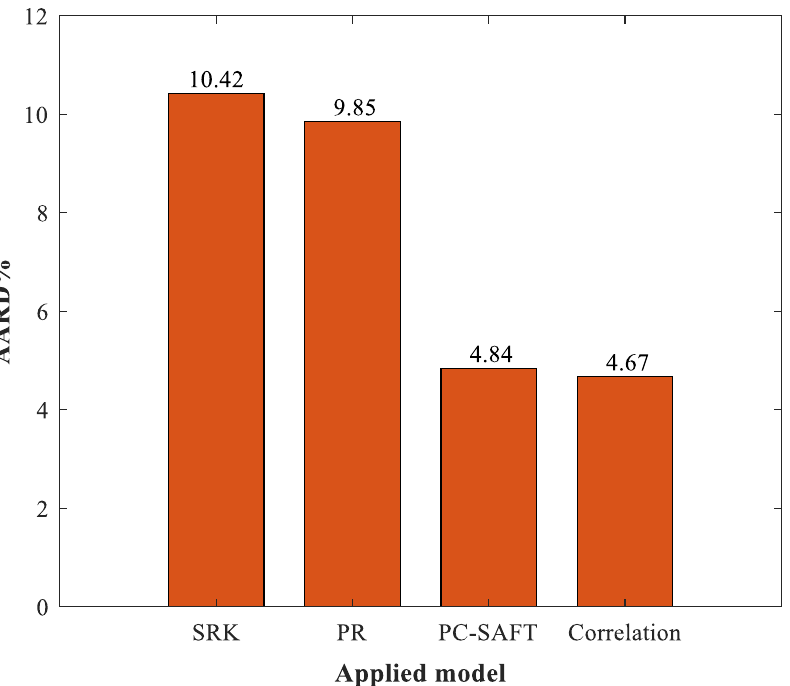
Figure 5. Accuracy of the predicted H 2 solubility in furfural by equations of state [28,29] and the Arrhenius type correlation.